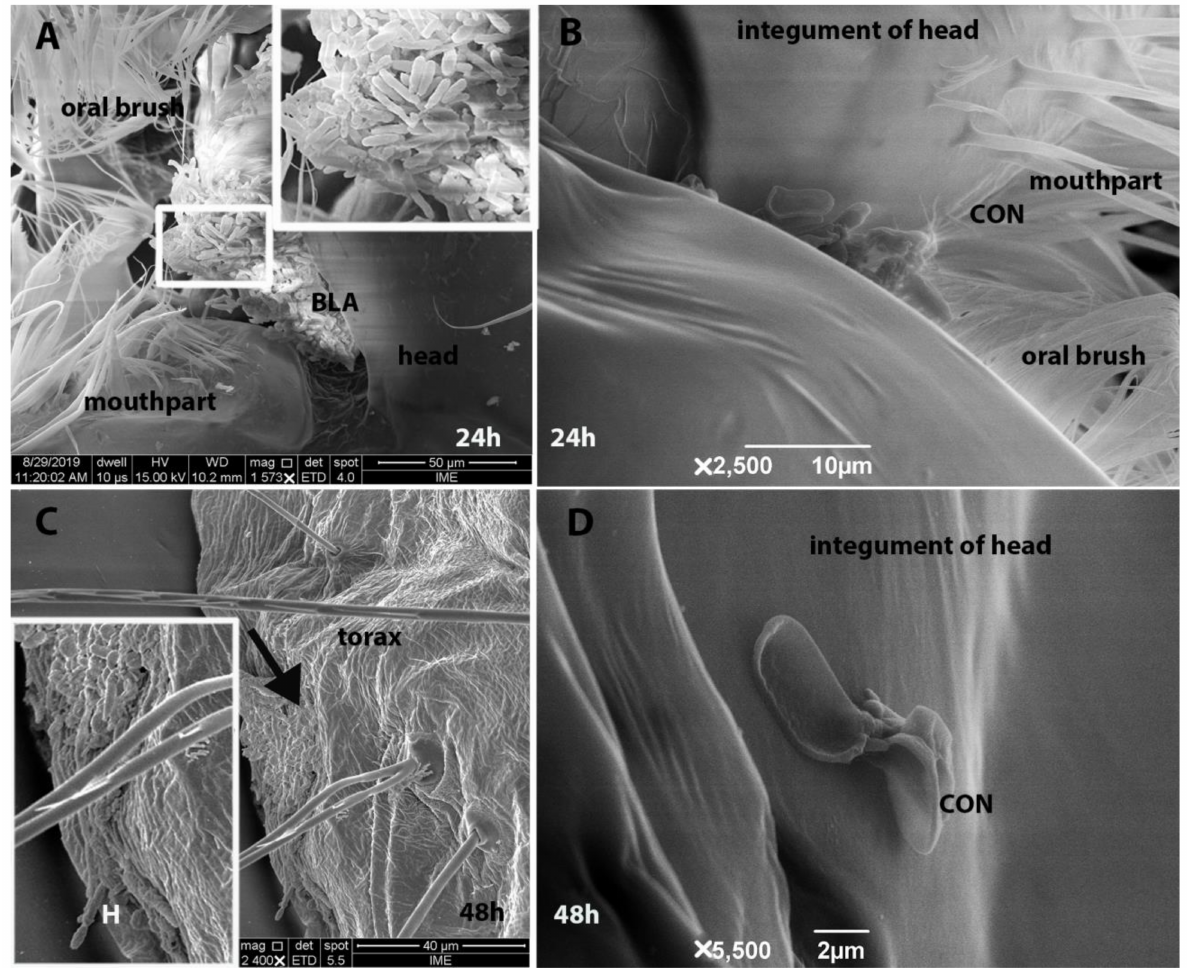
Figure 4. Scanning electron microscopy of Aedes aegypti larvae exposed for 24 h and 48 h to conidia or blastospores of Metarhizium anisopliae s.l CG 153 strain. ( A ) Blastospores at 24 h (BLA); ( B ) blastospores at 48 h (BLA); ( C ) conidia at 24 h (CON); and ( D ) conidia at 48 h (CON); hyphae